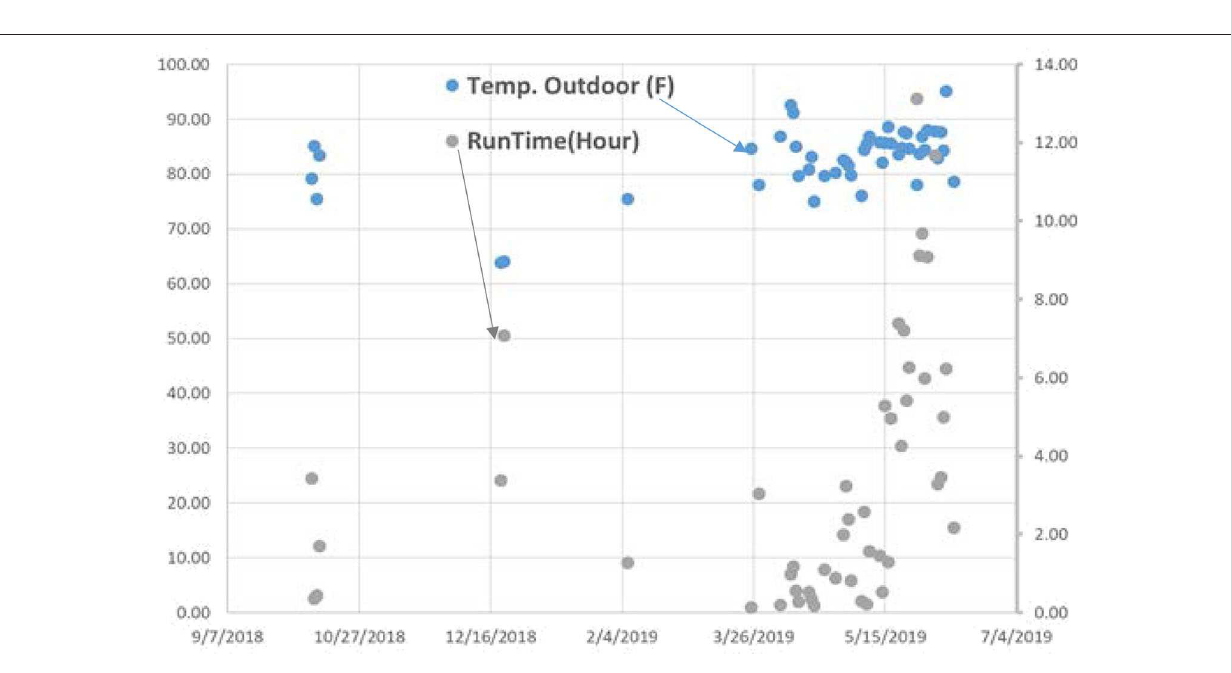
FIGURE 12 | The baseline run time of the HVAC